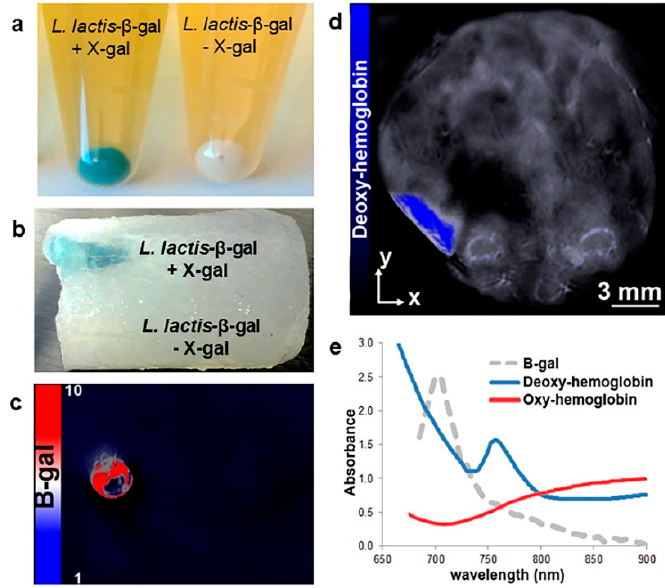
Figure 5. Characterization of L. lactis - β -gal as a contrast agent for in vivo MSOT imaging. ( a ) L. lactis - β -gal strain was cultured at 30 °C without agitation in GM17 (OD600 nm = 0.6–0.8). Cultures were incubated for 1 h at 37 ° C, and then X-gal was either added or not added to the cultures. Three hours later, a blue cell pellet was obtained by centrifugation. A pellet of cells from each culture is shown. ( b ) Cylindrical phantoms with a diameter of 2 cm were prepared using a gel made from distilled water, agar, and an intralipid 20% emulsion (to simulate light diffusion in vivo). ( c ) Phantoms containing L. lactis- β -gal with (left) or without (right) X-gal were imaged by MSOT using a transversal plane. ( d ) The orthogonal image shows tissue hypoxia of A375 tumors as corresponding to deoxygenated hemoglobin (blue bar). ( e ) The analysis of L. lactis - β -gal + X-gal and deoxy-hemoglobin spectra does not overlap, which suggests that both could be used simultaneously for multispectral unmixing of MSOT